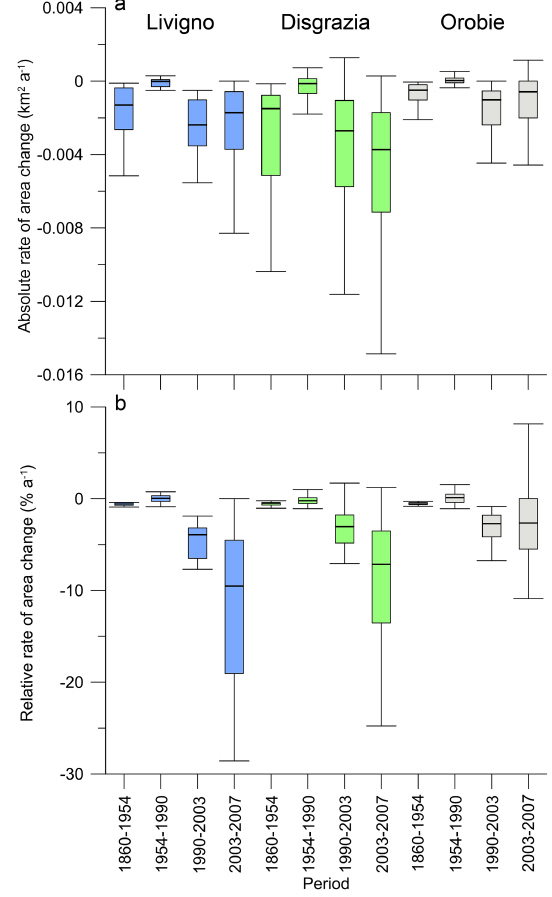
Figure 7. Boxplots showing (a) absolute rate of glacier area change and (b) relative rate of glacier area change. Horizontal lines indi- cate median values, boxes constrain the 25th and 75th percentiles, and whiskers mark the 10th and 90th percentiles. Outliers are not presented due to scale